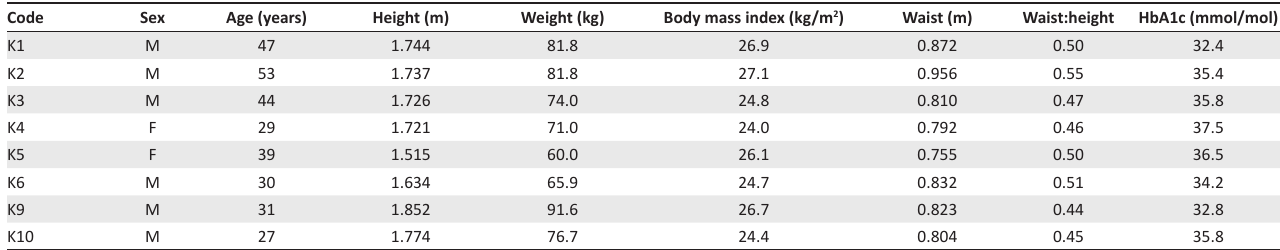
TABLE 1: Participant